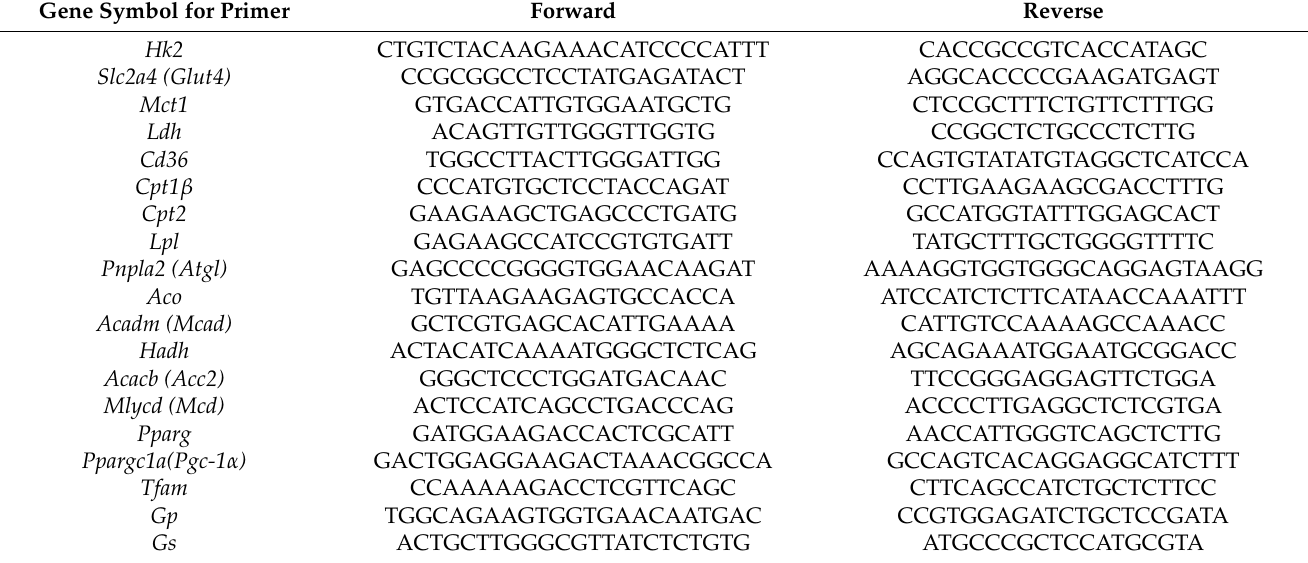
Table 1. Primer sequence for Real-Time PCR